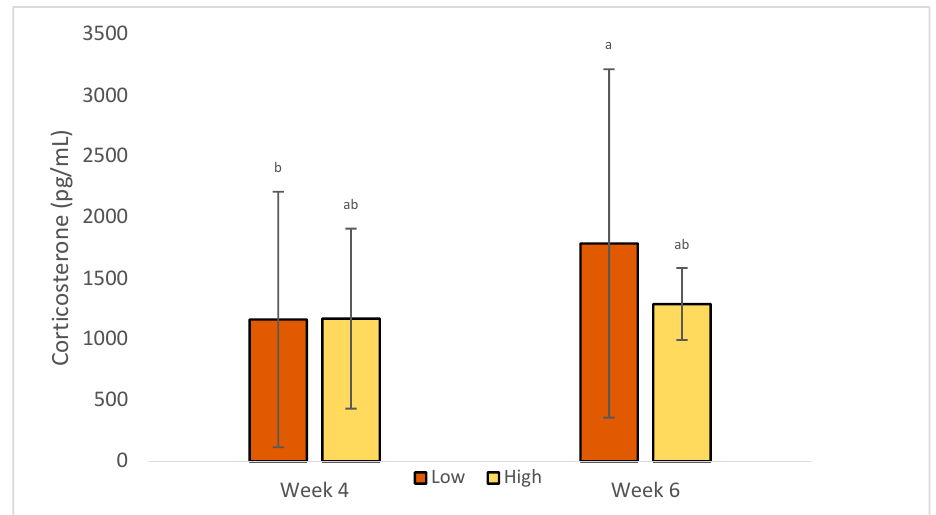
Figure 6. LS Means of the effects of density × week on corticosterone concentration of commercial-line broilers. Different superscript letters indicate statistically significant differences (Tukey’s HSD test; p ≤ 0.05).